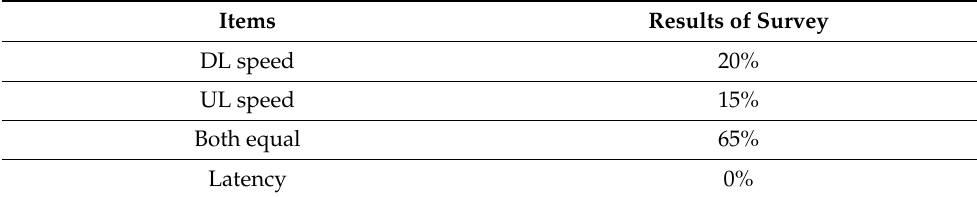
Table 6. Results of the